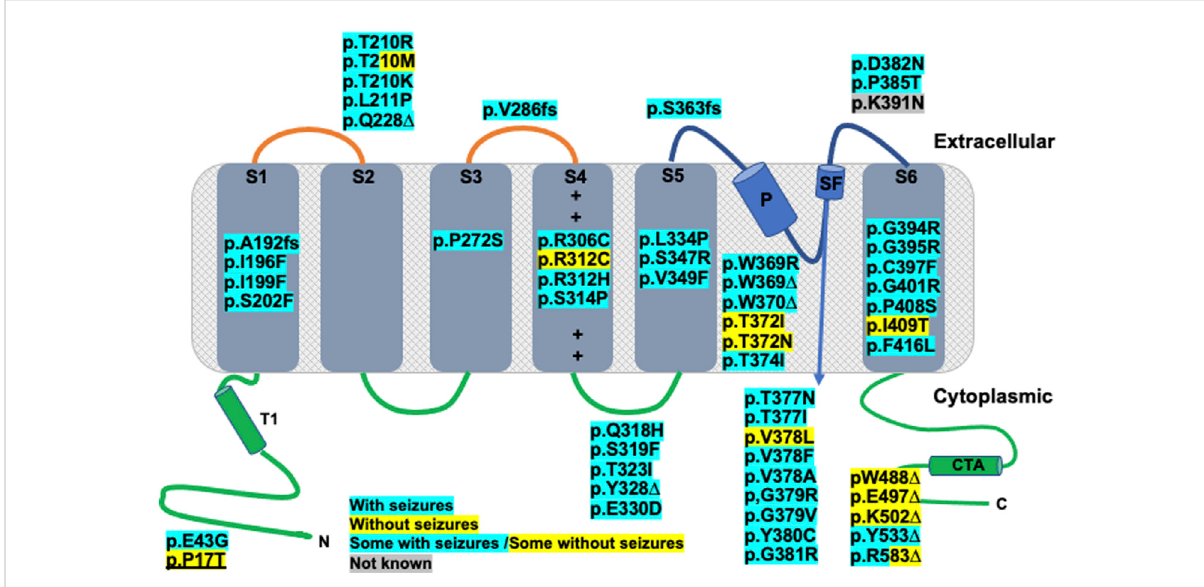
FIGURE 1 Kv2.1protein α -subunittopology schematicrepresentation,adaptedfromBaretal.,2020showinglocationofpublishedandnovel(underlined) clinical variants. Functional topology of single α -subunit consists of an N-terminal domain (N), residues 1 – 186, containing a tetramerization domain (T1), six transmembrane domains: S1 (residues 187 – 208), S2 (residues 229 – 250), S3 (residues 260 – 280), S4 (residues 295 – 316. + corresponds to positivelychargedaminoacidsofvoltagesensor),S5(residues331 – 351),S6(residues392 – 420),porehelix(P),residues365 – 376andselectivity fi lter (SF), residues 377 – 381 and C-terminal domain (C) and tetramerization domain (CTA), residues 421 – 858. Truncating variants are indicated with an Δ , whilst frameshift mutations are indicated with fs. All other mutations are missense. Any variants highlighted with blue correspond to patients with seizures, those highlighted yellow correspond to patients without seizures and blue/yellow corresponds to patients with and patients without seizure. For the variant highlighted grey, seizure data was not